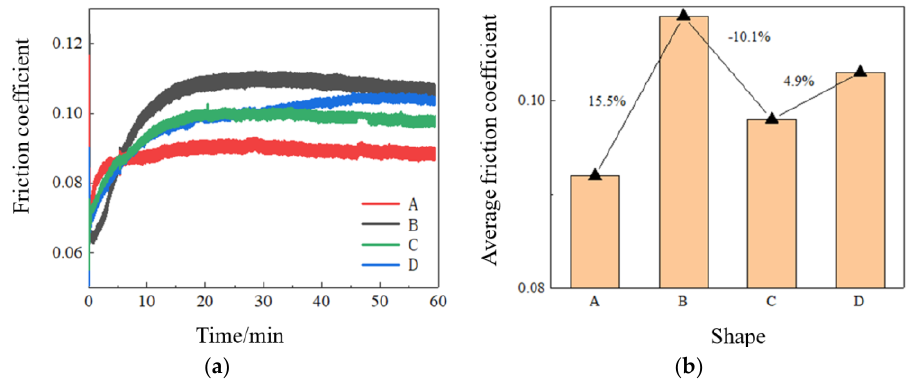
Figure 23. Influence of shape on surface friction coefficient. ( a ) Friction coefficient curve, ( b ) Average friction coefficient.